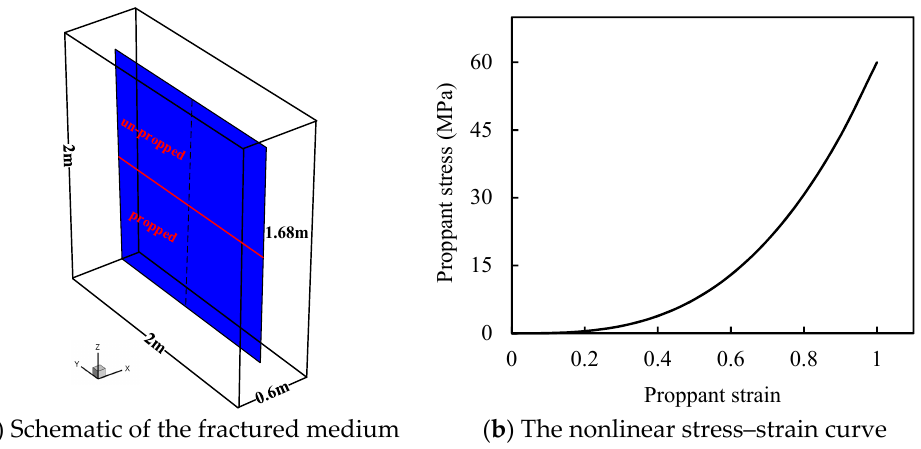
Figure 4. Schematic of a 3D fractured medium and the nonlinear stress–strain curve.